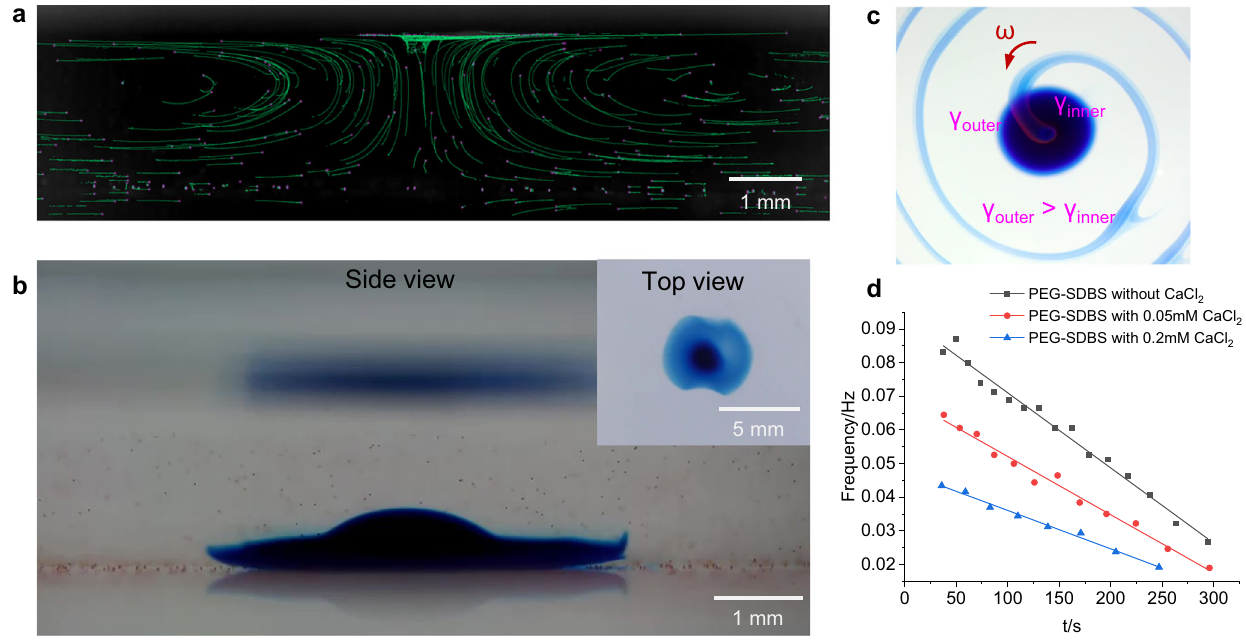
Fig. 7 | Initiation of the Marangoni transport system and rotation of the fi la- ment.a MarangoniconvectioninducedbythedepositionofatinyamountofDEX- MB-CaCl 2 (<0.05 μ L) on the surface of a PEG-SDBS solution (2.5mM) containing tracer particles (diameter 22 μ m) in a glass cuvette. The green lines are the tra- jectories of the PSparticles during 5s. The pinkdotsindicate thecurrent positions ofthePSparticles. b DiffusionofMBandCaCl 2 fromaDEX-MB-CaCl 2 droplet(1 μ L)